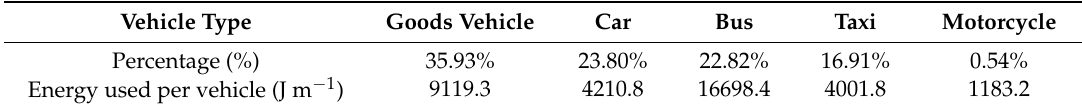
Table 2. Energy consumption and its percentage of each vehicle class type 1 .